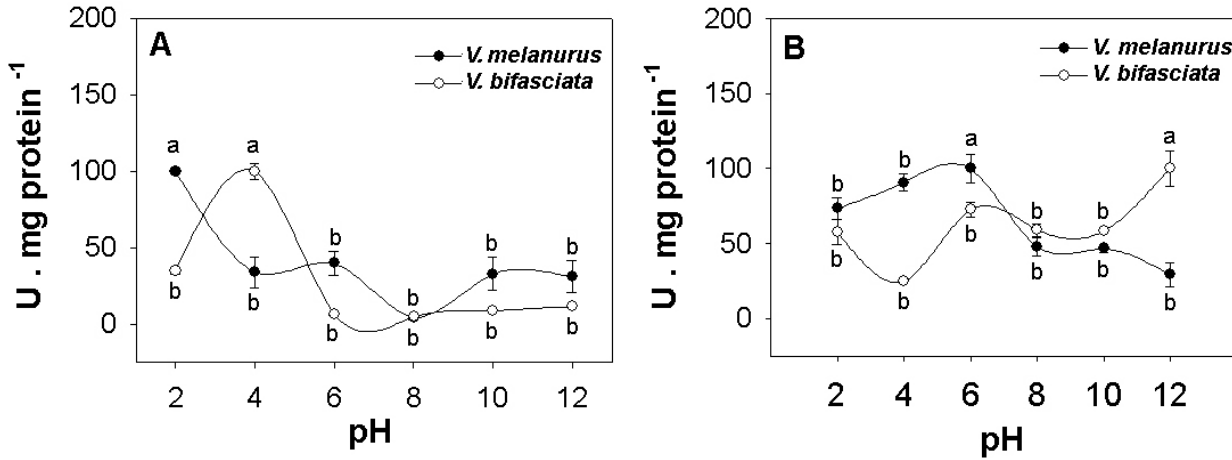
FIGURE 1 | Effect of optimal pH (mean ± SD, n = 3) on A . acid proteases and B . alkaline proteases of Vieja melanurus and V. bifasciata. Significant differences (P< 0.05) between pH values are shown by